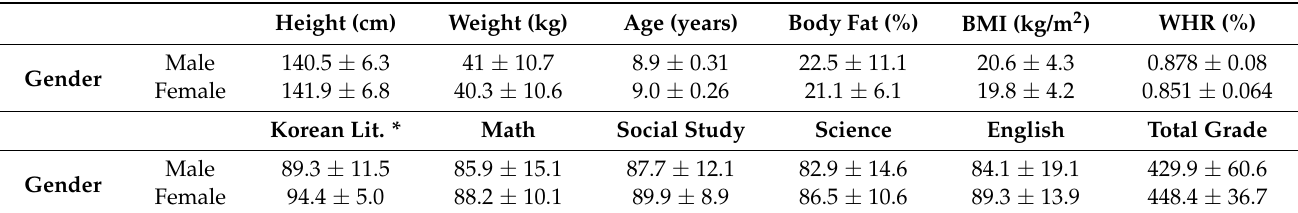
Table 1. Baseline anthropometrics and academic achievement data for the